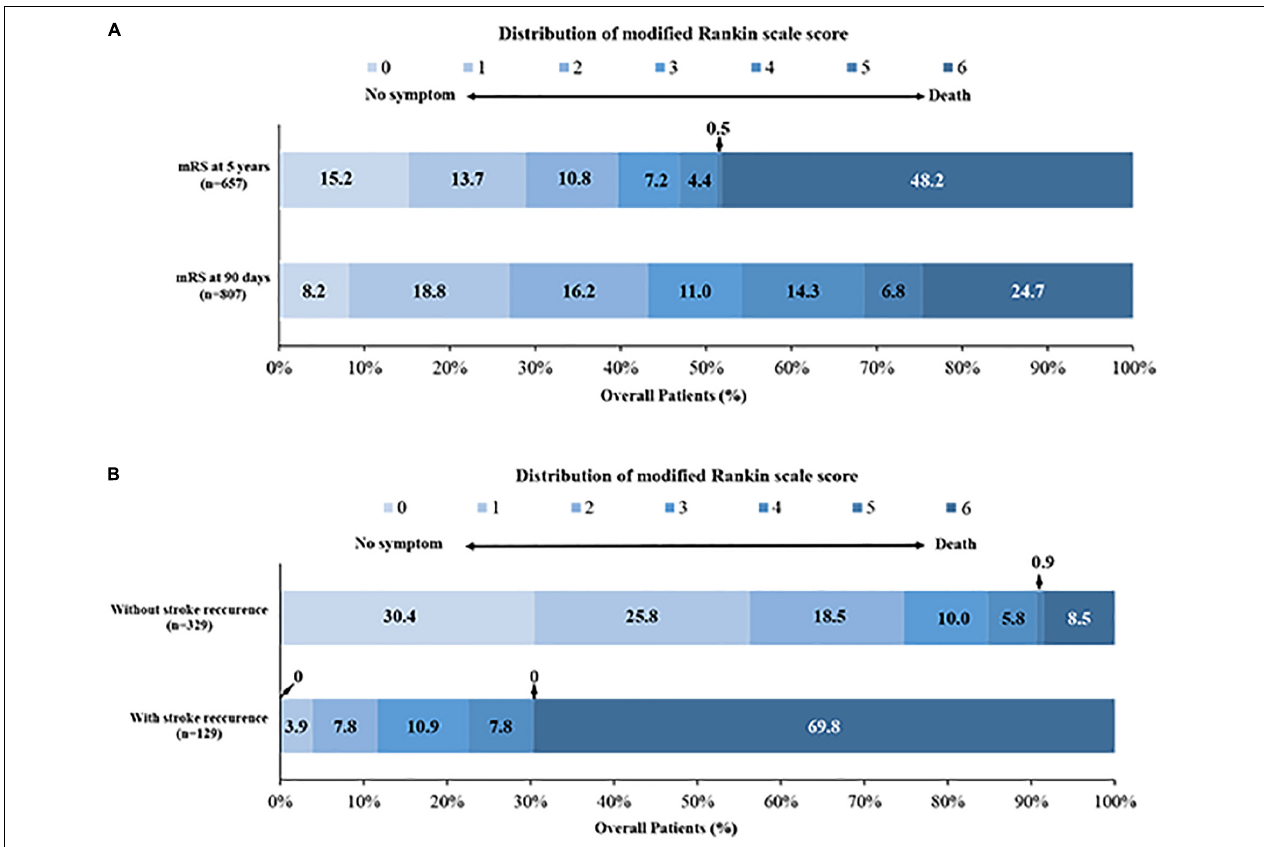
FIGURE 3 | Distribution of the modified Rankin scale score. (A) The distribution of mRS at 90 days and 5 years; (B) the distribution of mRS in patients with and without stroke recurrence at 5